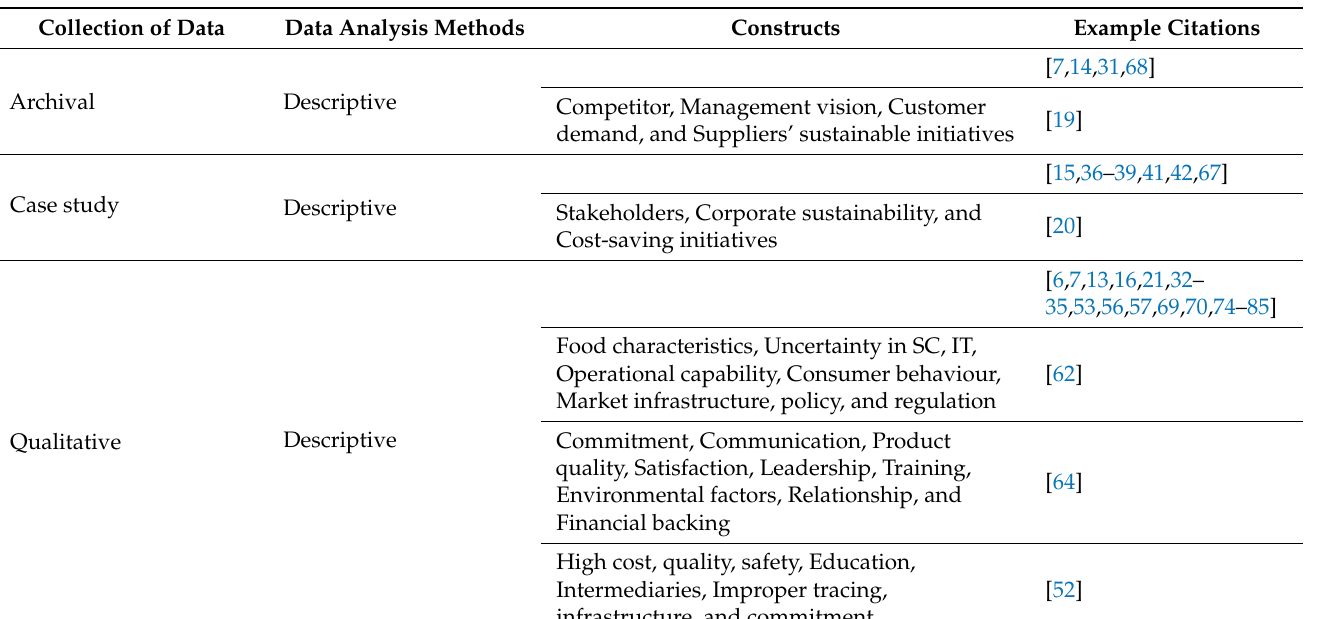
Table 6. Data collection and analysis techniques and Constructs, Source: The